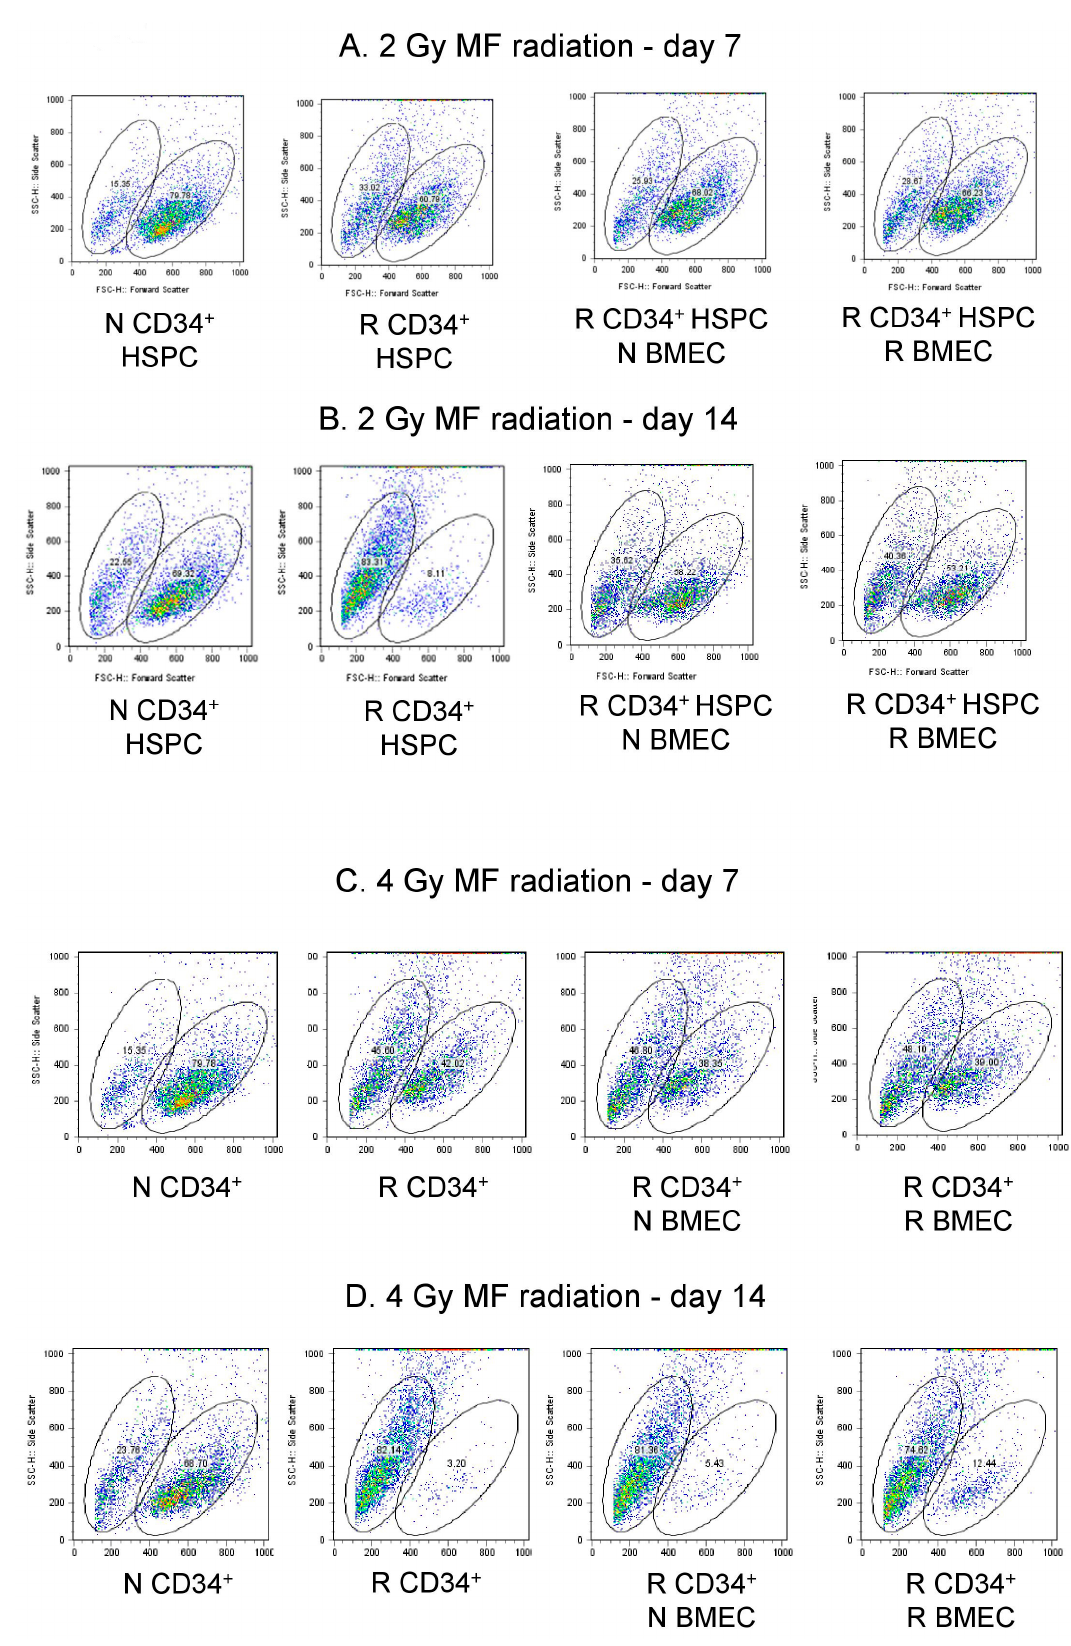
Figure 8. MF radiation and hBMEC altered scatter profile of HSPC. HSPC were irradiated with 2 Gy ( A , B ) or 4 Gy ( C , D ) for 7 or 14 days. Forward scatter was analyzed by flow